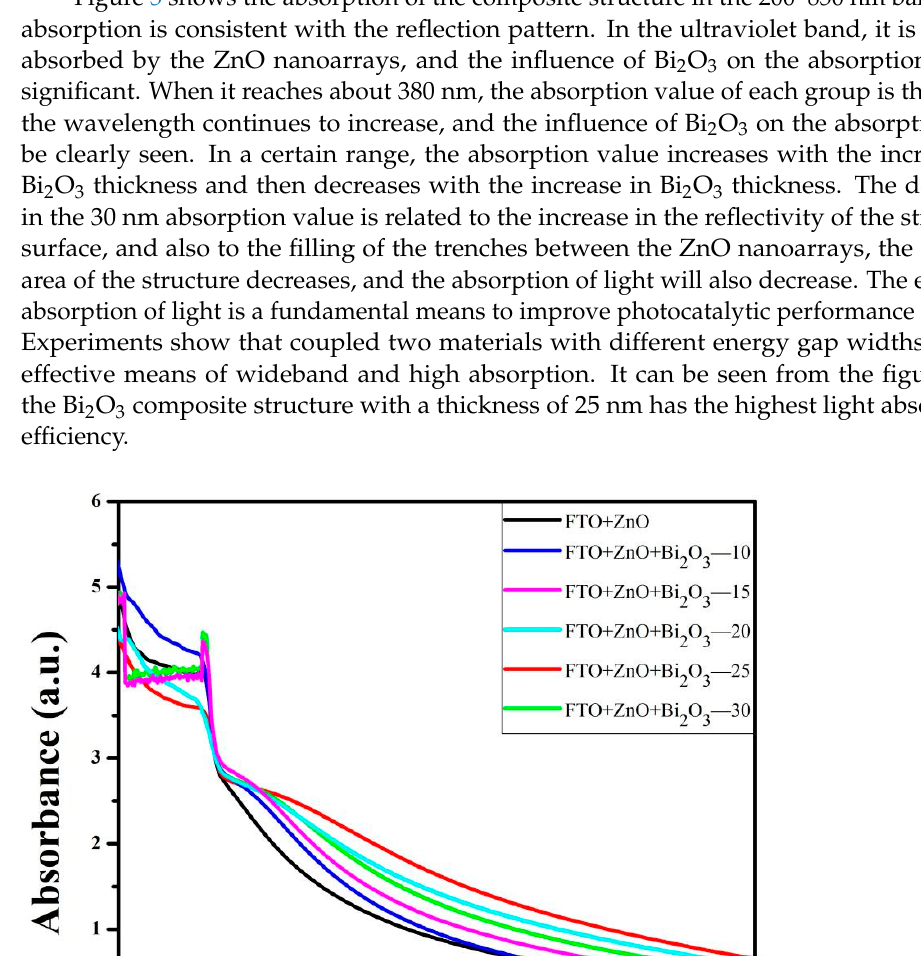
Figure 4. UV-Visible reflectance spectrum of the sample.